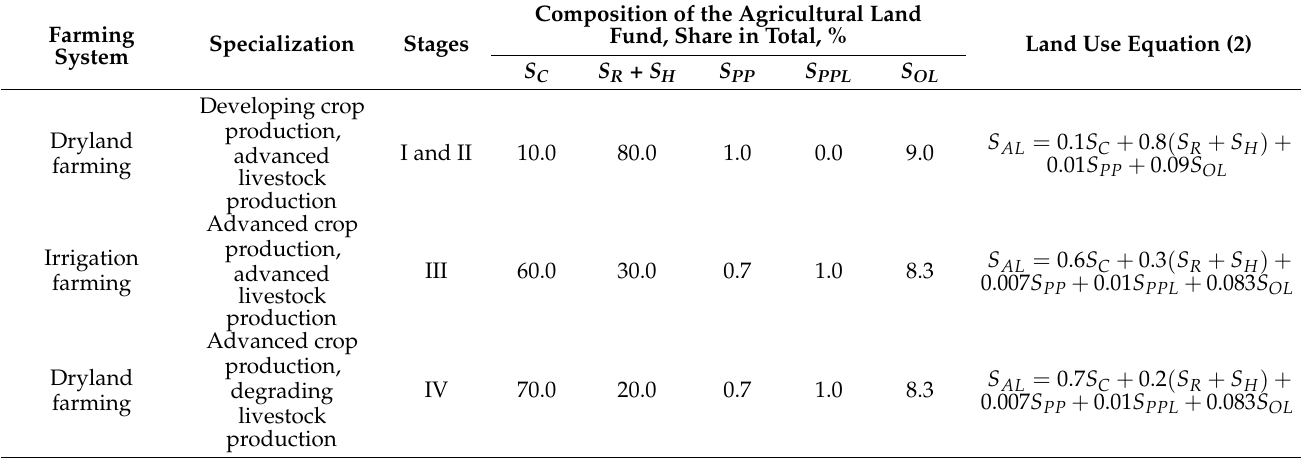
Table 3. Evolution of agricultural land use patterns in Central Fore-Caucasus in 1850–2020. Farming Specialization Stages System